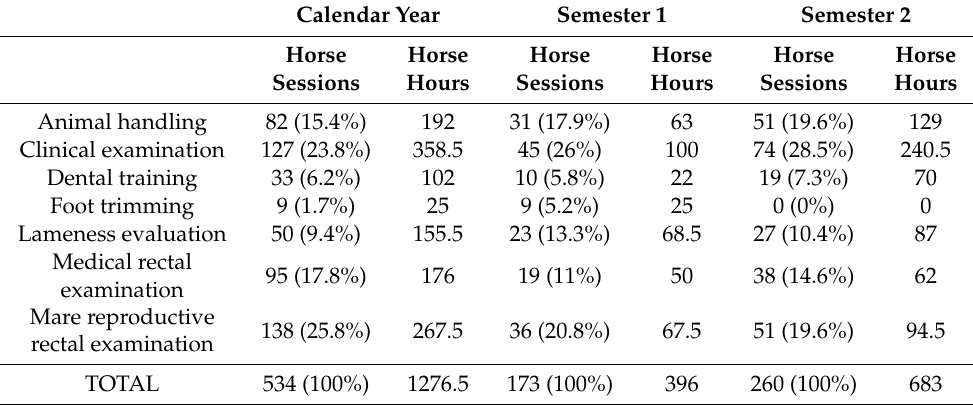
Table 4. The number of horse sessions and horse hours for each type of practical teaching class involving the use of horses during the 2018 calendar year and teaching semesters one and